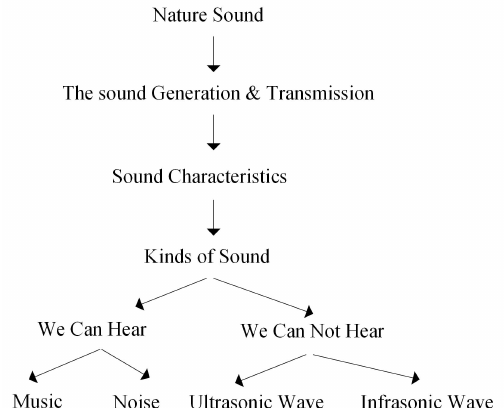
Fig. 3 “Physical” ontology O 3